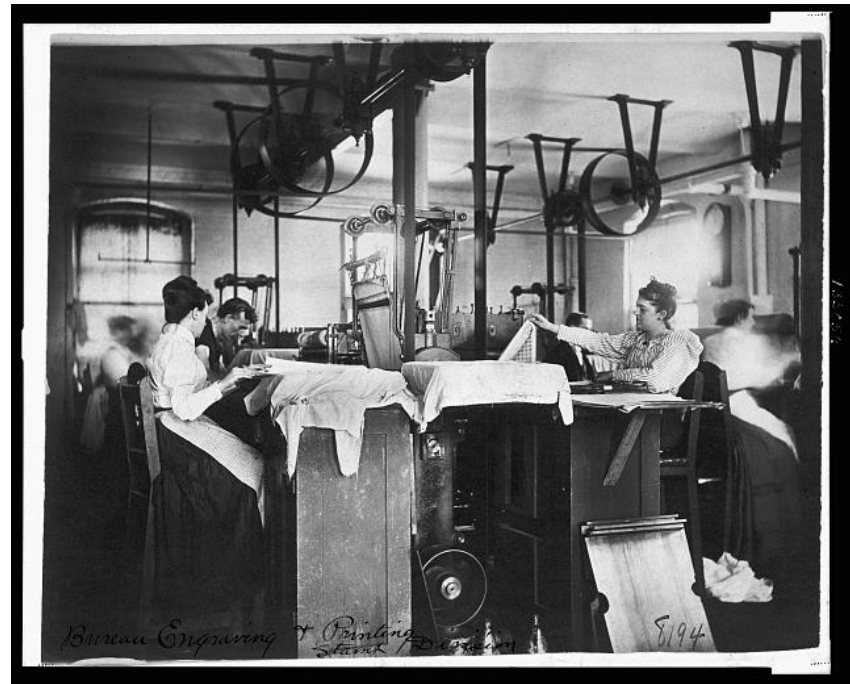
Figure 22. Frances Benjamin Johnston. 1895–1910. Bureau of Engraving & Printing—stamp division. Library of Congress.